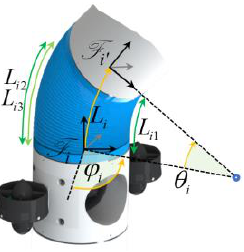
Figure 4. Configuration diagram of a soft joint.